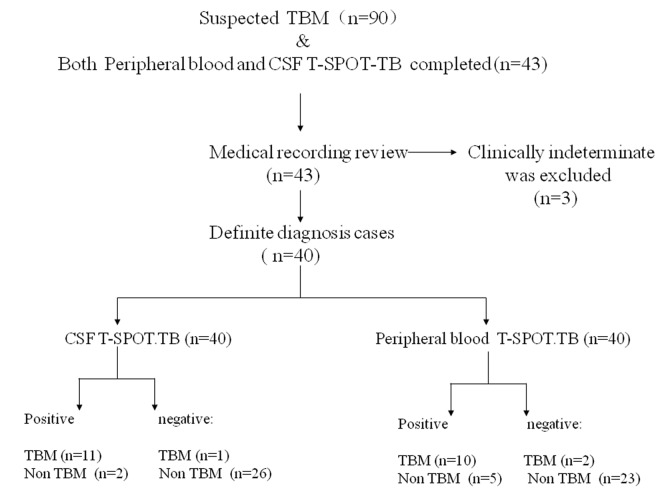
Study flow diagram.